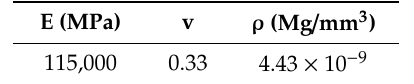
Table 4. Crack propagation (Paris law) for the Ti-6Al-4Va used in this paper (data adapted from [1]).